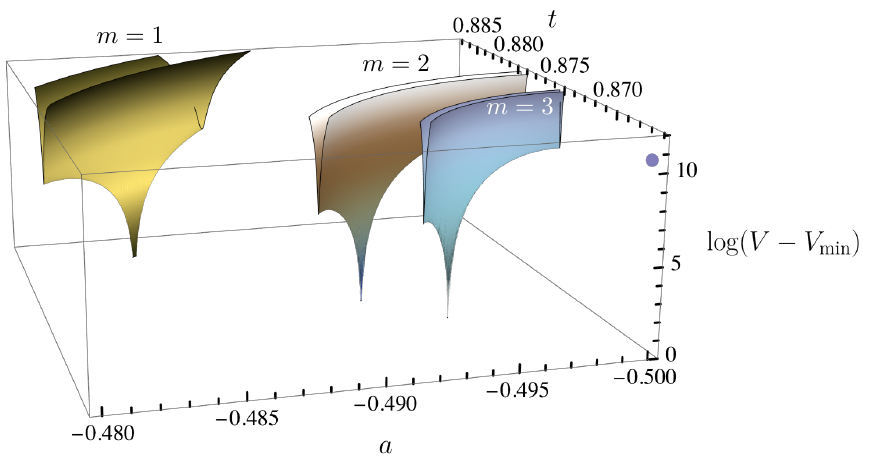
Figure 6 . Minima inside the fundamental domain close to the fixed point T = ρ at varying m and fixing n = 0 in the function H ( T ) . The higher m , the closer the minimum is to the point ρ , which in this setup is a maximum and is represented by the blue dot. Each plot is appropriately